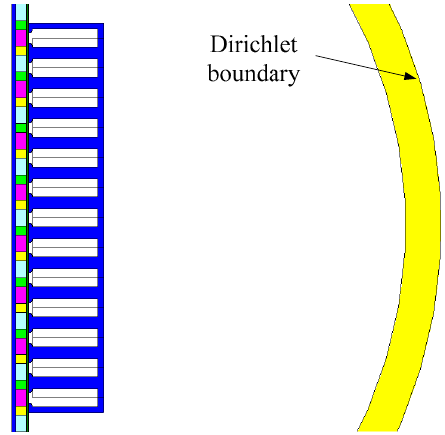
Figure 2. Finite element model of the PMLM.